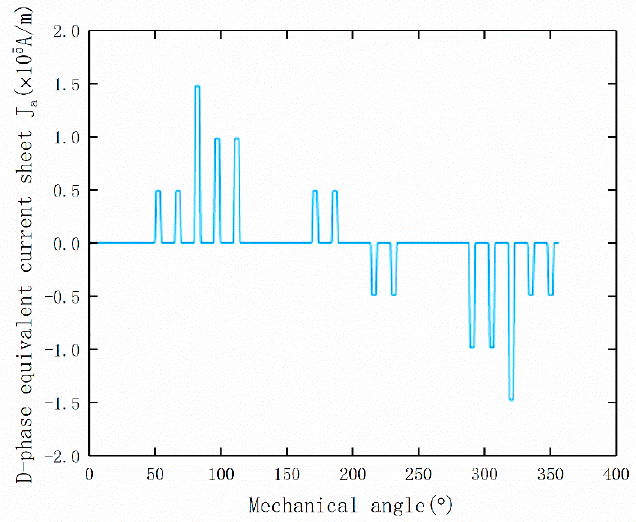
Figure 3. The three-phase synthesis equivalent current distribution.